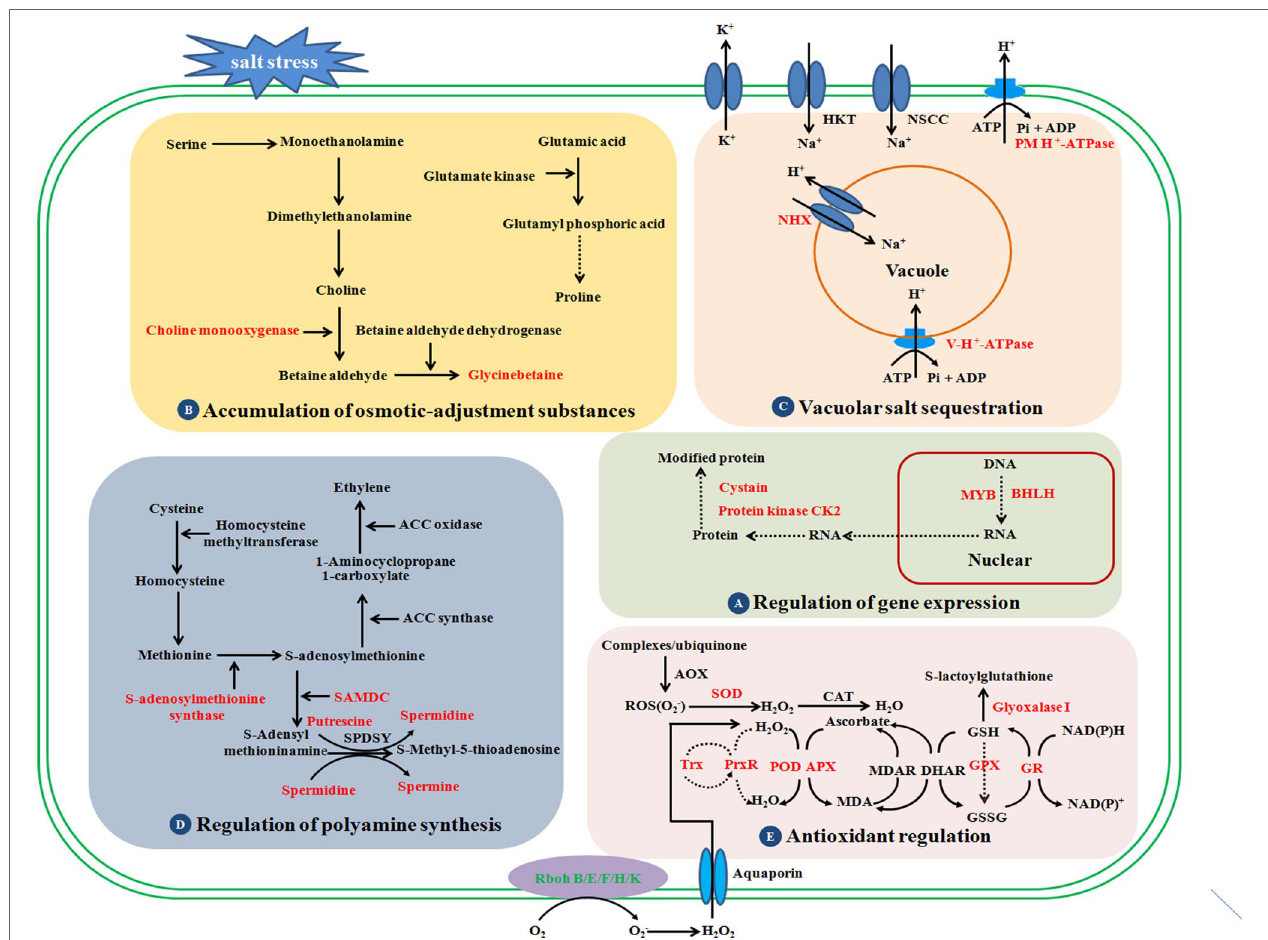
FIGURe 2 | Schematic presentation of the potential mechanisms underlying salt stress tolerance in sugar beet. Red-highlighted genes or proteins play key roles in determining the salt tolerance of sugar beet. Sugar beet can improve its salt tolerance through the following regulation strategies: regulation of gene expression, accumulation of osmotic-adjustment substances, vacuolar salt sequestration, regulation of polyamine synthesis, and antioxidant regulation. NHX, Na + /H + antiporters; SOD, superoxide dismutases; Prx, peroxiredoxins; POX, peroxidase; APX, ascorbate peroxidase; CAT, catalase; GR, glutathione reductase; SAMDC, S-adenosylmethionine decarboxylase; RBOH, respiratory burst oxidase homologue; GPX, glutathione peroxidase; CK2, casein kinase; NSCC, non-selective cation channels; HKT, high affinity transporter; GST, glutathione S-transferase, MDAR, monodehydroascorbate reductase; DHAR, dehydroascorbate reductase; MDA, monodehydroascorbate; ROS, reactive oxygen species; AOX, alternative oxidase.